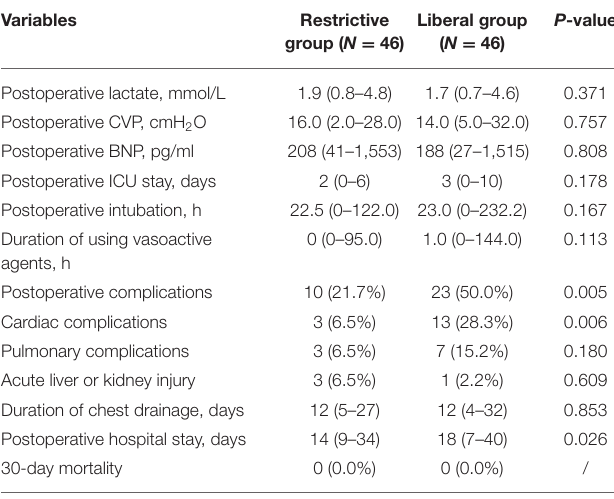
TABLE 2 | Comparison of restrictive and liberal groups on postoperative outcomes. Variables